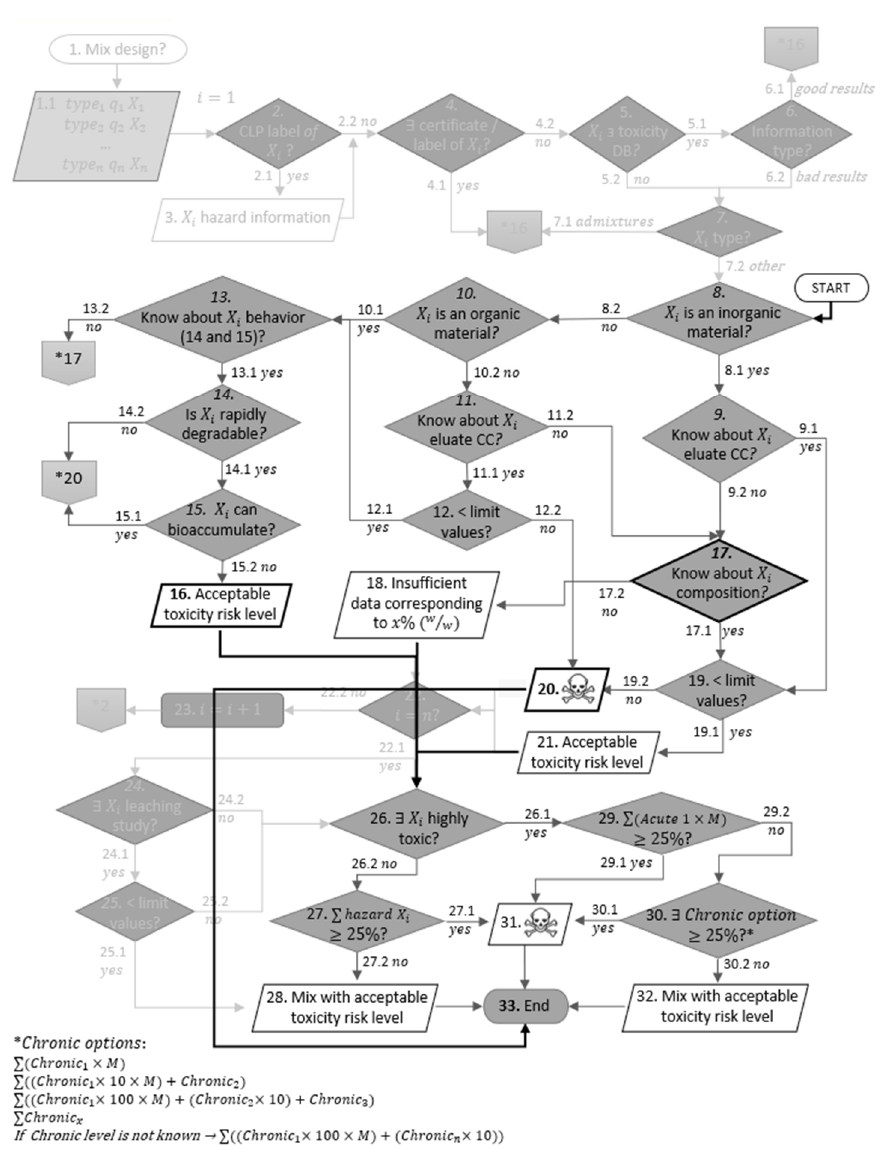
Figure 1. Flowchart of the applied methodology (adapted from [34]—original flowchart as watermark and adaptations highlighted in bold).